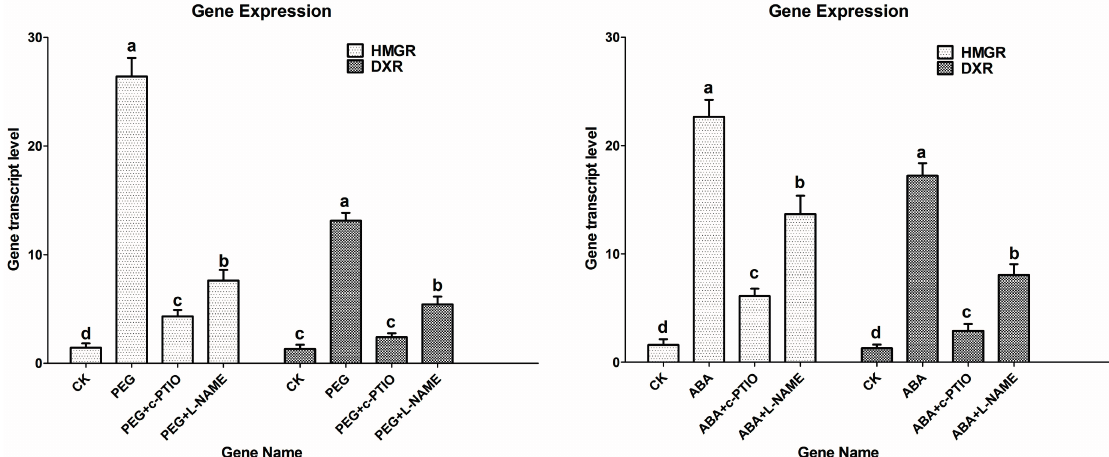
Figure 4. Expressions of HMGR and DXR induced by 2% PEG and 200 µM ABA. HMGR , hydroxymethyl glutaryl-coenzyme A reductase gene; DXR , 1-deoxy-D-xylulose 5-phosphate reductoisomerase gene; CK, the control; PEG, polyethylene glycol; ABA, abscisic acid; L -NAME: N ω -nitro- L -arginine methyl ester, 200 µM; c-PTIO, 2-(4-Carboxyphenyl)- 4,4,5,5-tetramethylimidazoline-1-oxyl-3-oxide, 200 µM. Different letters (a, b, c and d) indicate significant difference at p ≤ 0.05. Means ± standard deviation (S.D.) ( n = 3) are